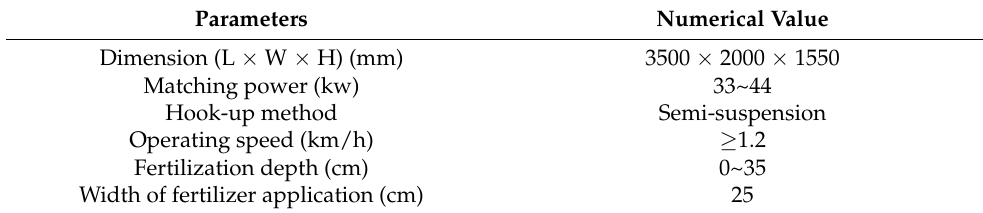
Table 1. Main technical parameters of the whole machine.